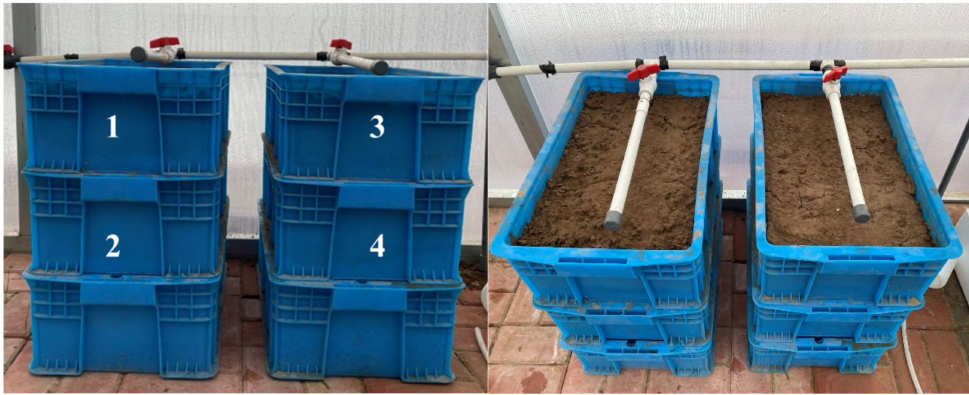
Figure 2. Photos of multistage soil box percolation